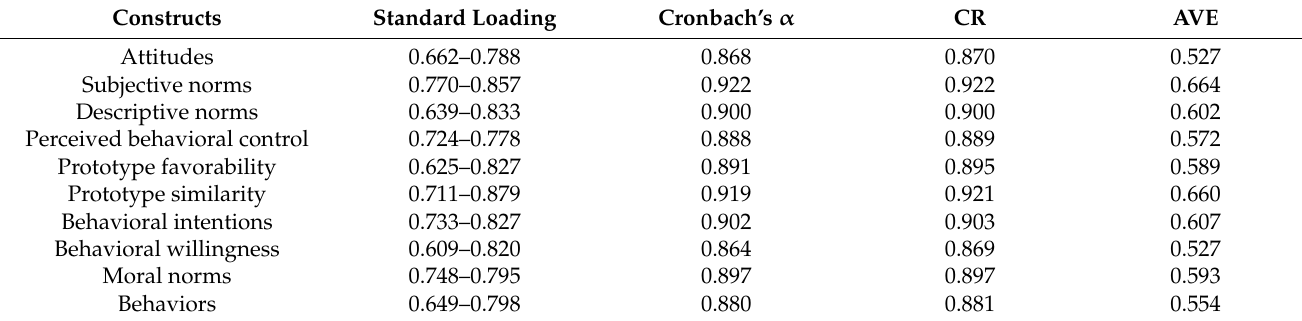
Table 1. The reliability and convergence validity of the latent variables.